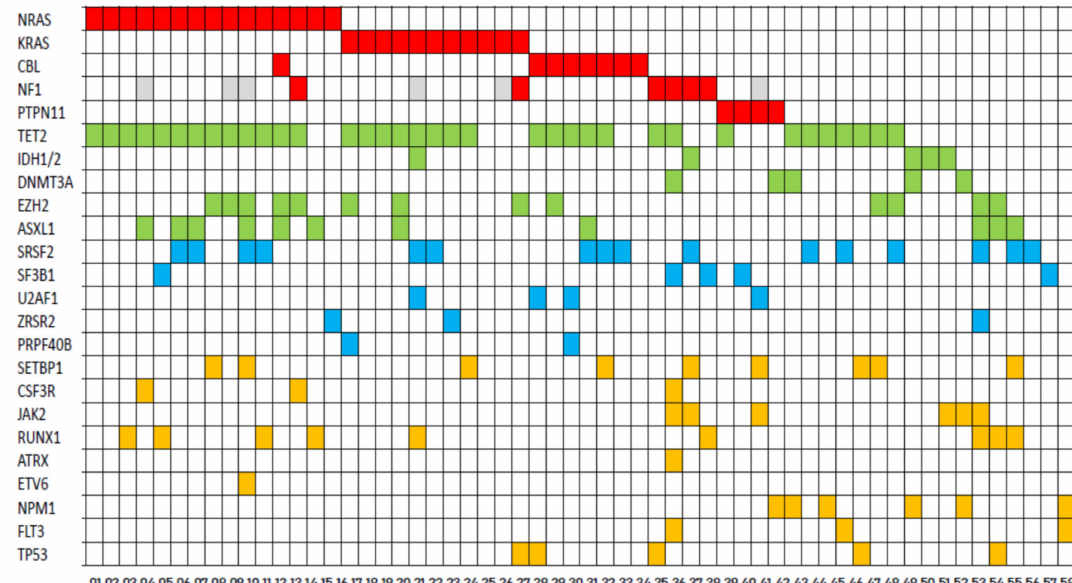
Figure 3. Comprehensive mutation status of genes in patients with CMML derived AML. Each column correspondstoonepatient. Coloredsquaresindicatemutated, whitesquareswild-typegenes. Thecolors of mutant genes indicate the most a ff ected functional categories. Red, green, blue, and yellow represent the RAS-pathway, epigenetic regulators, spliceosome, and other components, respectively. Missing data are indicated by gray squares.